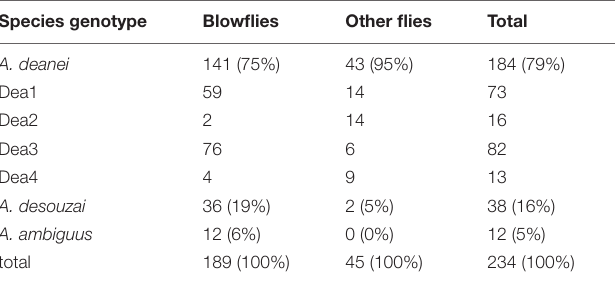
TABLE 1 | Identification of Angomonas species and genotypes in cultures a and guts of blowflies b and other flies c based on V7V8 SSU rRNA plus gGAPDH and/or symbiont-GAPDH